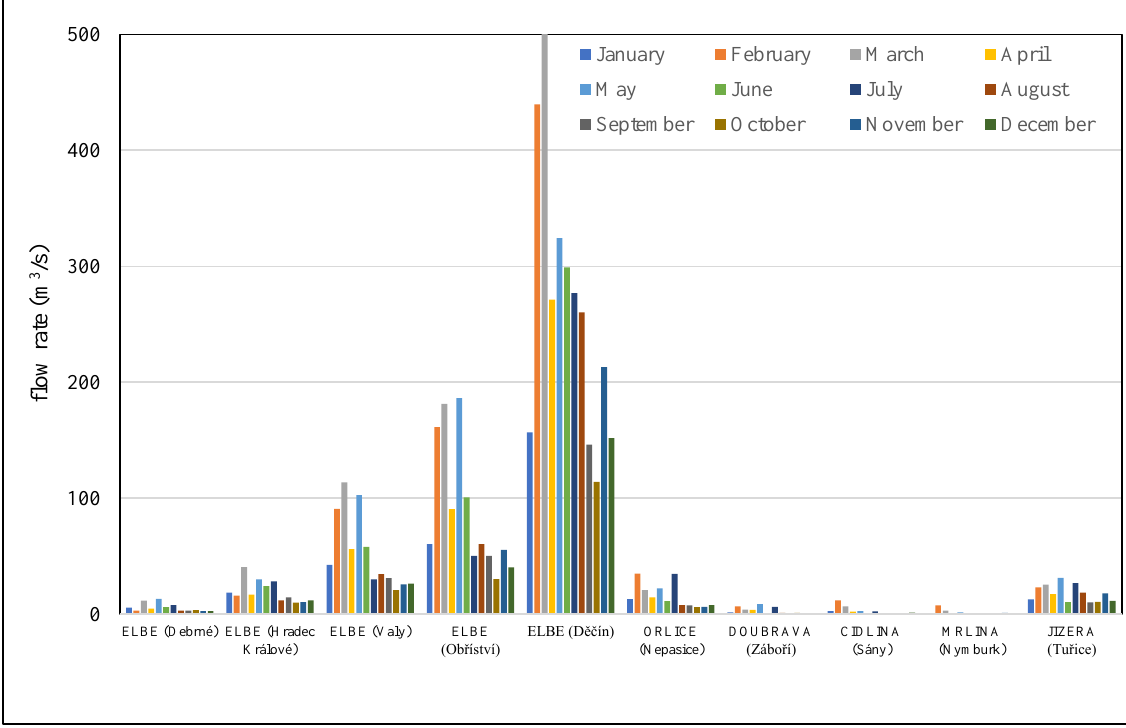
Figure 7. Daily average flow rate at monitored sites of the Elbe River basin.